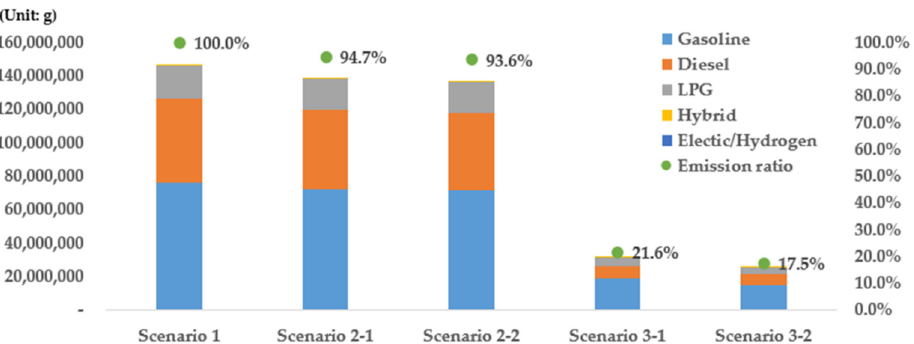
Figure 16. Vehicle emissions and emissions ratios by fuel type. Table 3. Vehicle emissions and reduction efficiency by fuel